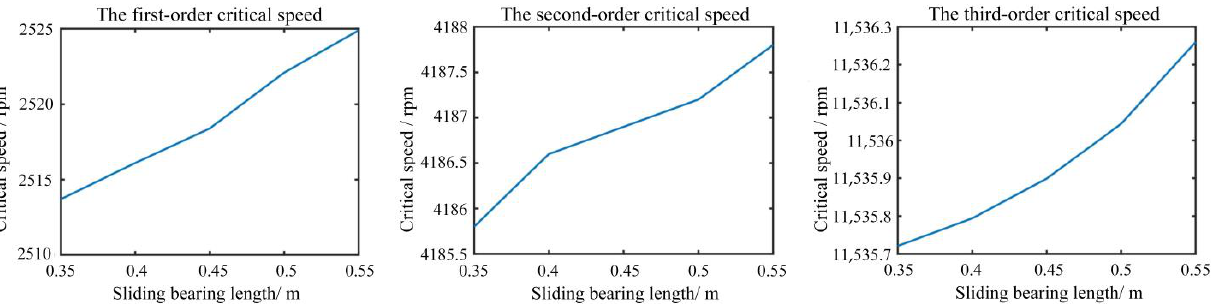
Figure 11. Influences of the sliding bearing length L b on the first three critical speeds.